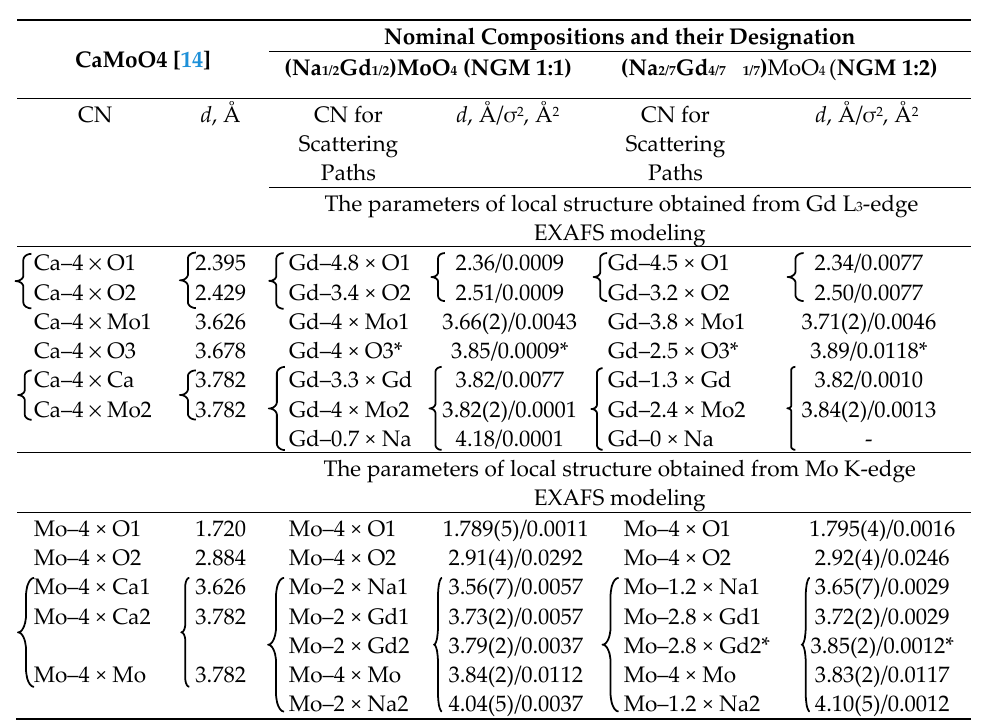
Table 7. The results of two-sphere EXAFS fit for NGM 1:1 and NGM 1:2 crystals ( k -range: 2–13 Å − 1 ): coordination number, CN; interatomic distance between the central atom and the next neighbors (the length for single scattering path), d , Å; the Debye–Waller factor, σ 2 . The braces are combined atoms belonging to the same coordination sphere.